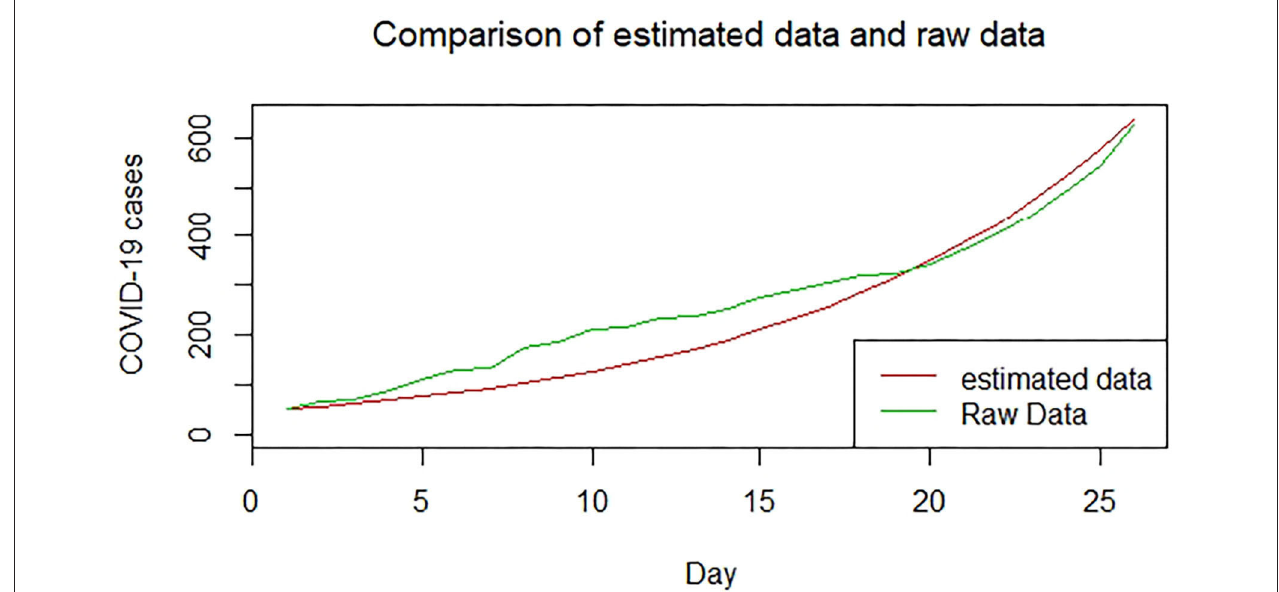
FIGURE 24 | Graph for Nigeria.